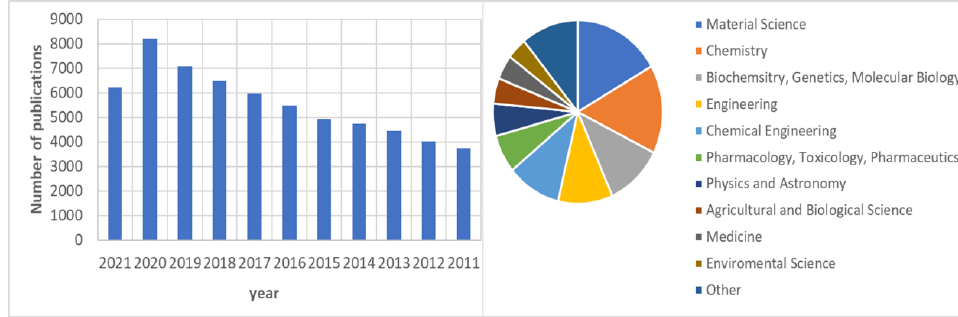
Figure 11. Number of publications and distribution by area in the period 2011 – 2021. Search of chitosan word in Scopus (abstract, title, keywords).